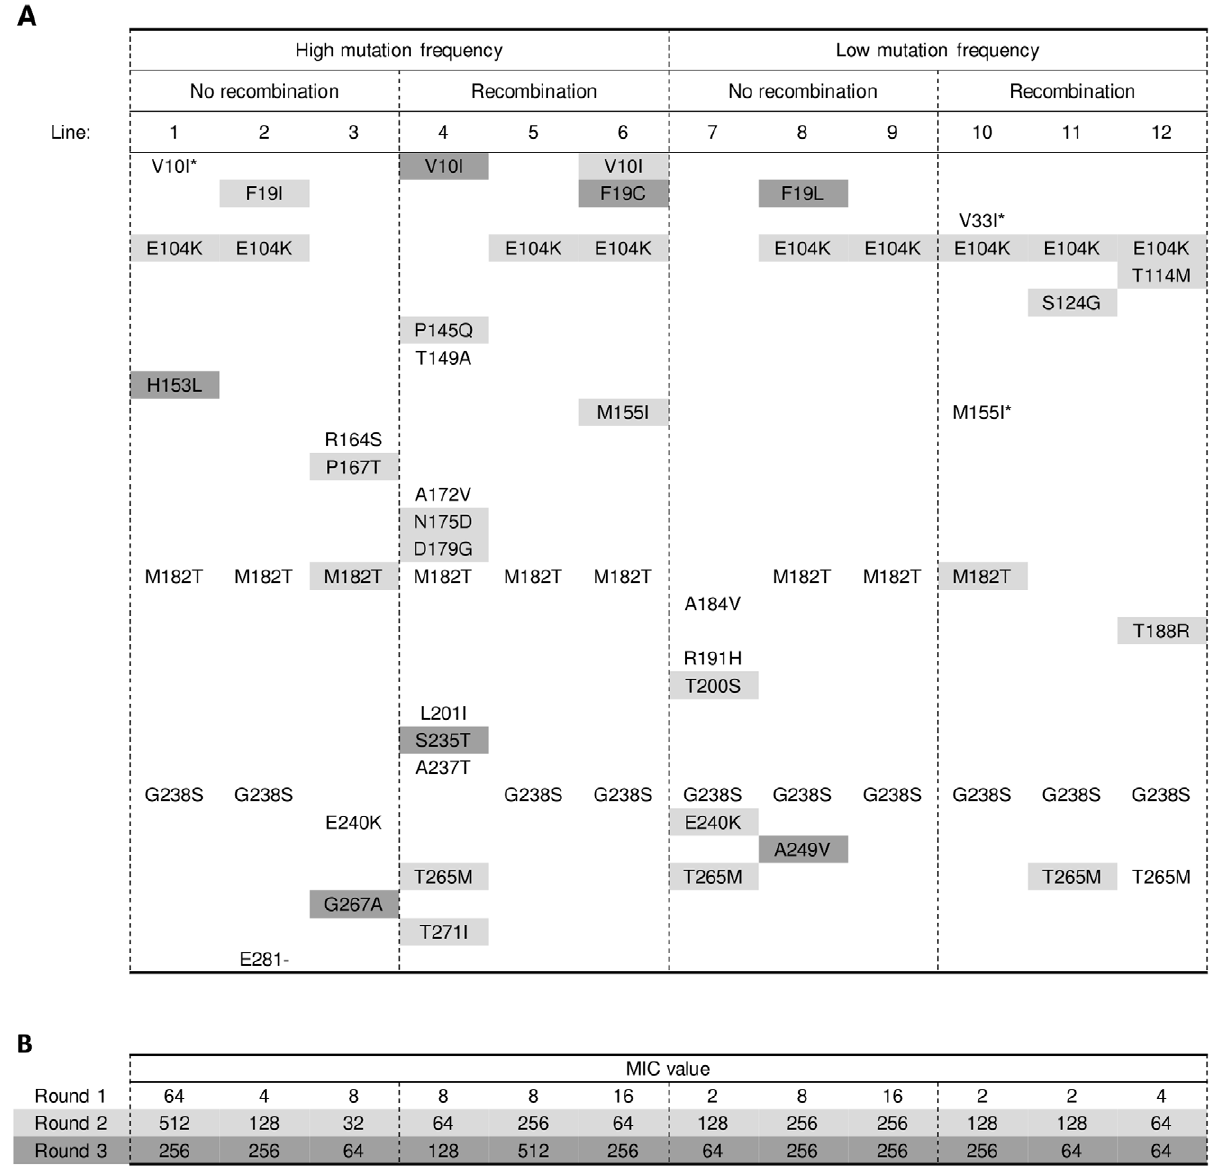
Figure 2. Amino acid substitutions in evolved TEM-1 alleles. (A) Substitutions are shown as the TEM-1 amino acid according to the IUPAC single-letter code (left), the position in the protein [39] (middle), and the mutant amino acid (right). Substitutions found after the first round (and hence in all subsequent rounds) have no shade, those found after the second round have a light shade and those found after the third round have a dark shade. The three substitutions indicated with an asterisk appeared in the first round, but disappeared again after round 2 (V33I and M155I in line 10) and round 3 (V10I in line 1). Mutation details (including the official nucleotide numbering as in reference [40]) and silent mutations can be found in Table S1. (B) MIC values of the alleles isolated after the different rounds of evolution, as shown in (A). Values shown are the median value across three replicates (see Table S3 for replicate measurements). Shading as above.